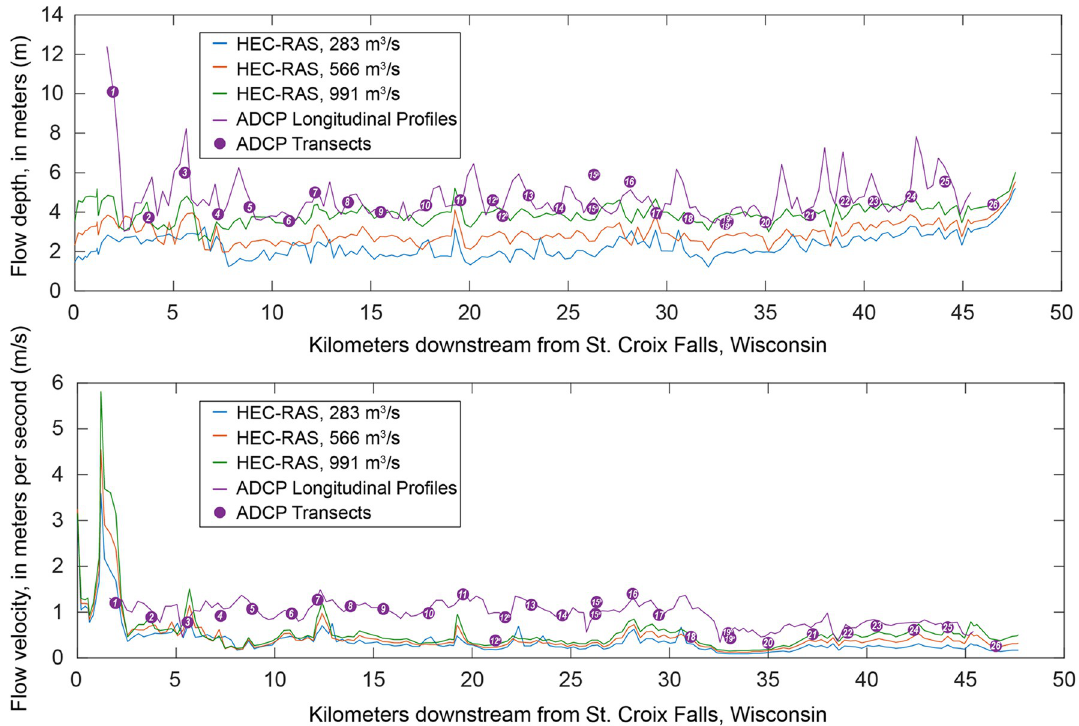
Fig 6. Plots of simulated U.S. Army Corps of Engineers Hydrologic Engineering Center’s River Analysis System (HEC-RAS) and observed (acoustic Doppler current profiler [ADCP]) flow depths throughout the 47.8-km study reach shown in the top panel. Bottom panel shows simulated and observed flow velocities for the same reach. Observed depths and velocities were collected during June 2018 ADCP surveys, while HEC-RAS results are obtained from steady-state simulations of three representative discharges during the June 2018 sampling